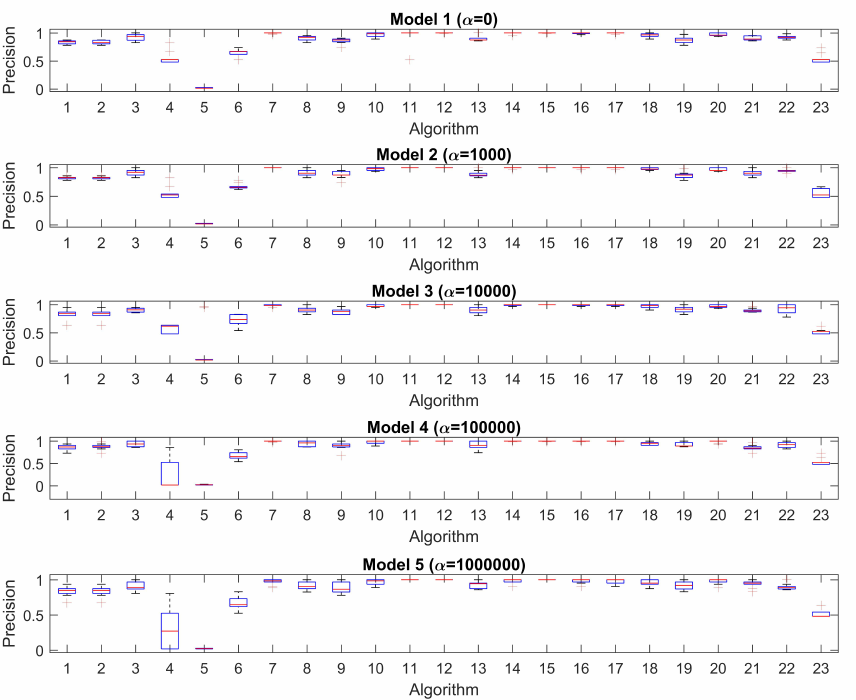
Figure A4. Numerical simulation Assumption 2. Precision of various models after permutations in the numerical values of the mapping. The 23 algorithms are represented in the x -axis, and the accuracy is shown in the y